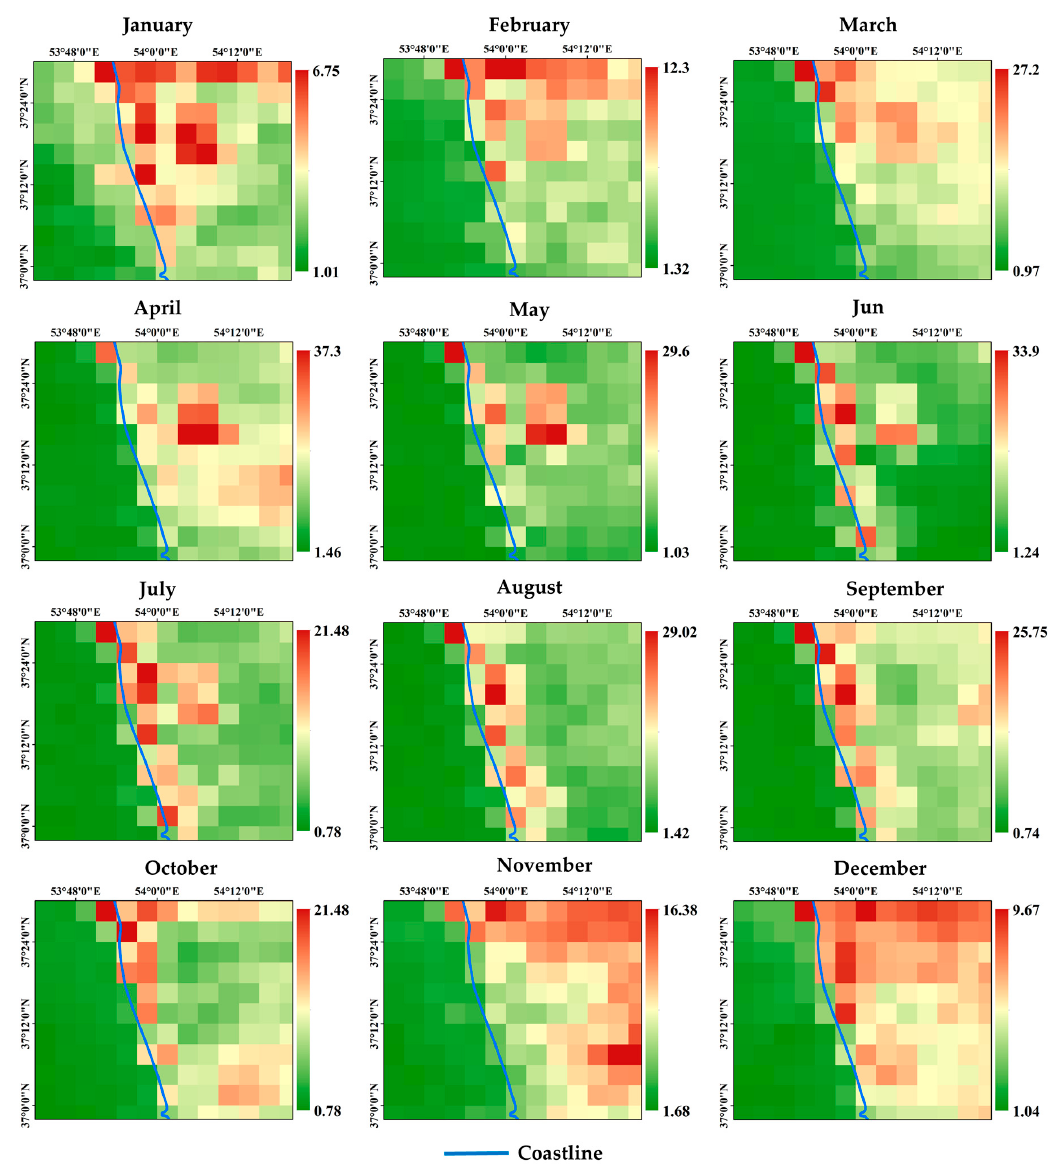
Figure 6. Variance maps of LST for different months in the period of 2000–2017.